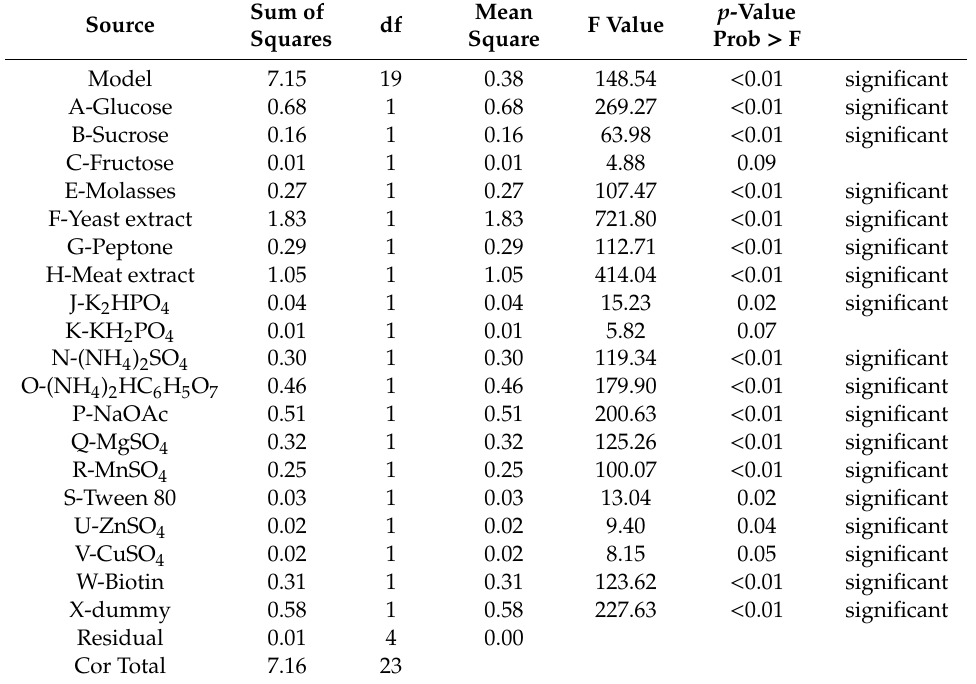
Table 3. ANOVA of PBD for the e ff ects of medium components on the growth of P. acidilactici